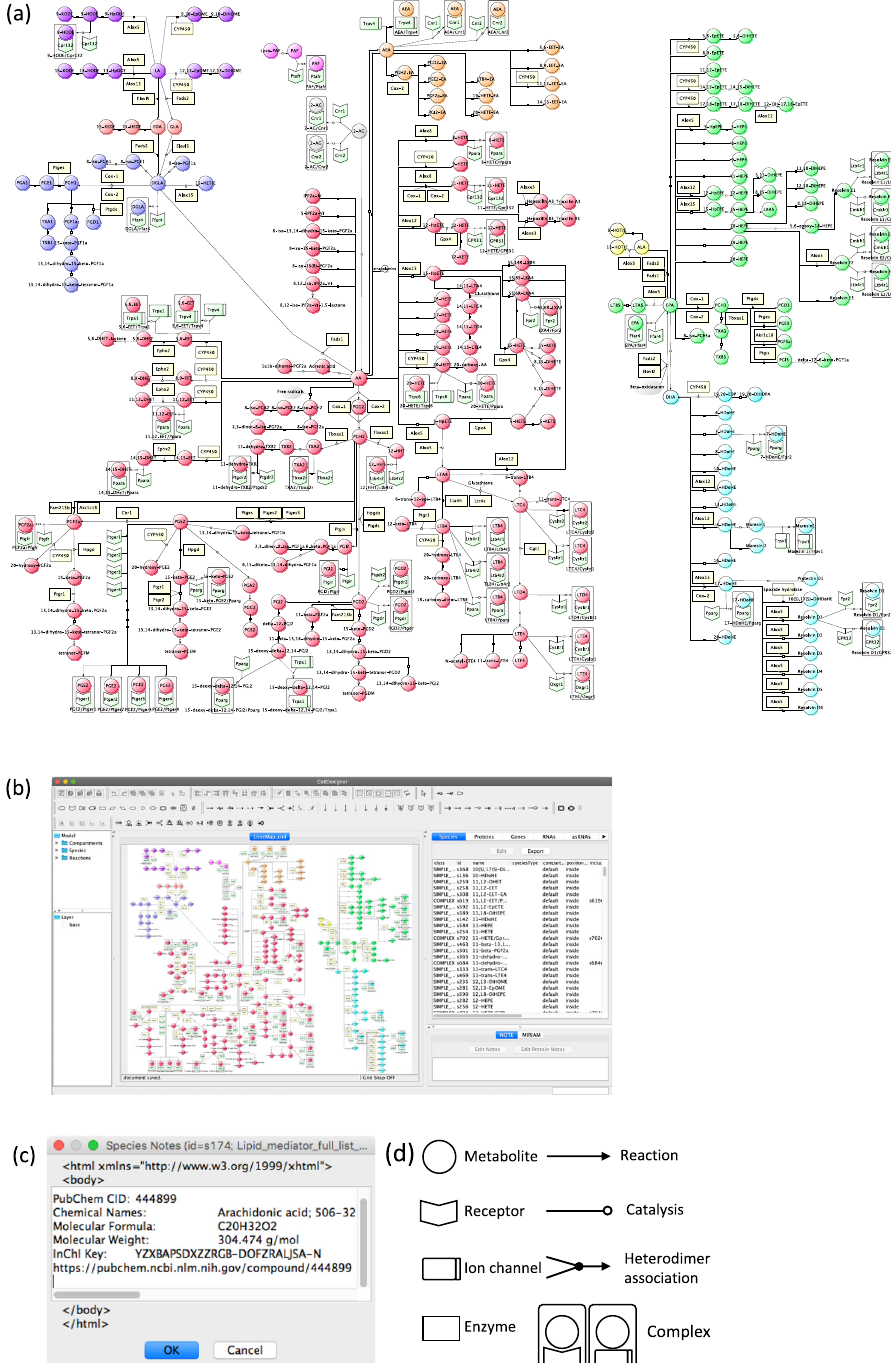
Fig. 1 Lipid mediator metabolic pathway map (LimeMap). a LimeMap includes a total of 282 factors (222 lipid mediators and metabolites, 60 enzymes and receptors) and 279 reactions. The LimeMap fi le, SBML compliant format created with CellDesigner version 4.4, is available as Additional Data (LimeMap.xml). The list of lipid metabolite abbreviations is provided in Supplementary Table 1. The magni fi ed pathway maps are shown in Supplementary Fig. 1. b The SBML fi le is opened in CellDesigner. c Information on each factor is annotated in the notes section. d De fi nition of the symbols used to build the map. Circle symbols show metabolites, square symbols in light yellow show enzymes, arrowhead symbols show receptors, and separated square symbols show ion channels. Complexes of metabolite and receptor or ion channel are indicated with a grey-colored square. Lines with an arrow show metabolic reactions, lines with an open circle connected to a metabolic reaction show enzymatic reactions, and arrowhead symbols with two connected lines show heterodimer association. Color coding indicates the grouping of metabolites; Red for AA derived lipid mediators, purple for LA derived lipid mediators, salmon pink for GLA and EDA derived lipid mediators, blue for DGLA derived lipid mediators, pink for Lyso-PAF and PAF, orange for AEA derived lipid mediators, yellow for ALA derived lipid mediator, light green for EPA derived lipid mediator, and light blue for DHA derived lipid